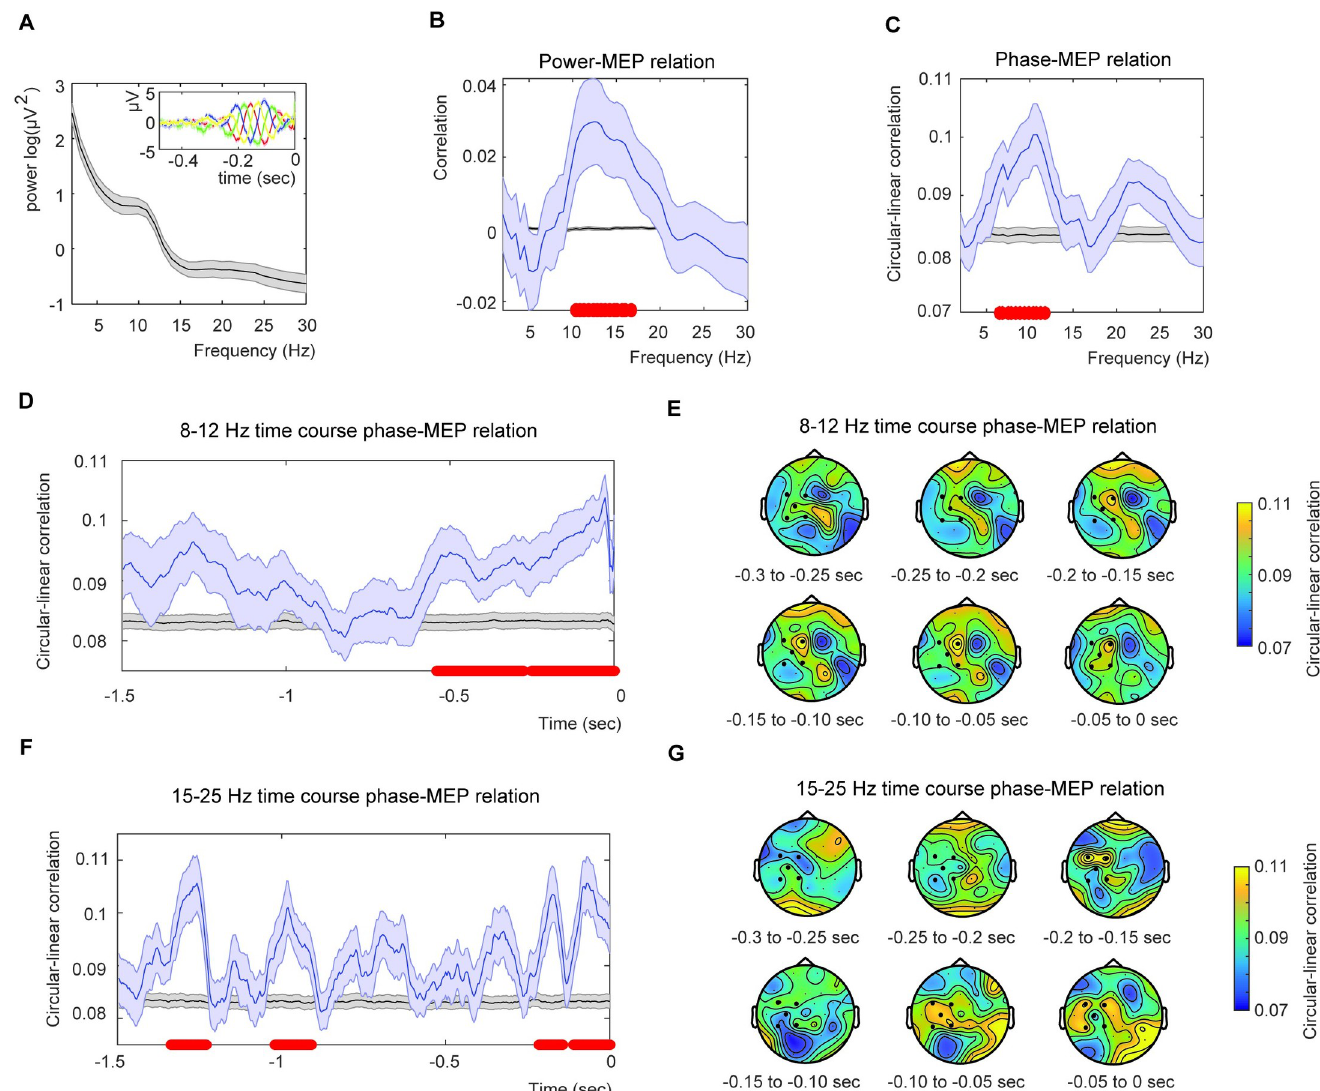
Fig 1. Results for the power and phase analysis. A) Mean power averaged from the EEG channels C3, FC1, FC5, CP1 and CP5. The inset shows the (unfiltered) ERPs for four different equally spaced phase bins in channel CP1 for alpha. This figure demonstrates that there is no phase bias in our estimation. B) Averaged power-MEP correlation for the five selected channels (blue) and the average permutation (black). C) Average circular-linear phase-MEP correlation for the five selected channels (blue) and the related permutation (black). Red dots indicate significance at alpha = 0.05 (cluster corrected). D) Phase-MEP relation extracting the instantaneous alpha phase via the Hilbert transform displaying the time course of the effect. Color coding identical to C). E) Phase correlation topography based on the Hilbert analysis. The strongest correlation was present at CP1. All shaded areas indicate the standard error of the mean. F) and G) are identical to D) and E) but for the beta frequency range (15–25